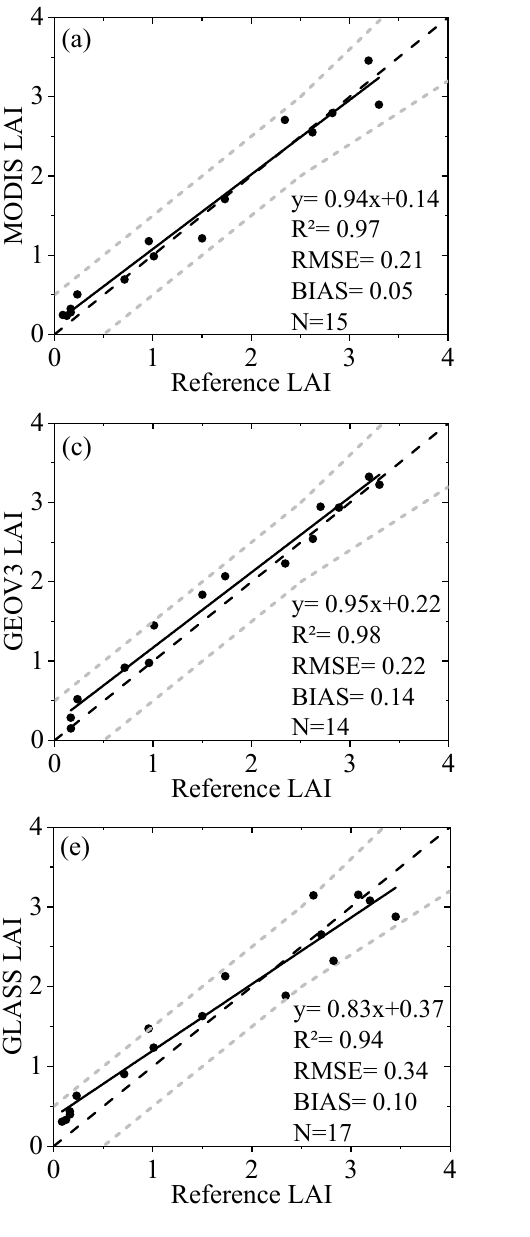
Figure 7. Comparison between ( a ) MODIS, ( b ) GEOV2, ( c ) GEOV3, ( d ) EPS, ( e ) GLASS and ( f ) C3S V2 with the reference LAI. The black dashed line indicates 1:1 line, and solid line indicates linear regressions between LAI products and reference LAI. The gray dashed lines show the Global Climate Observing System uncertainty requirements for LAI (max (0.5, 20%)).